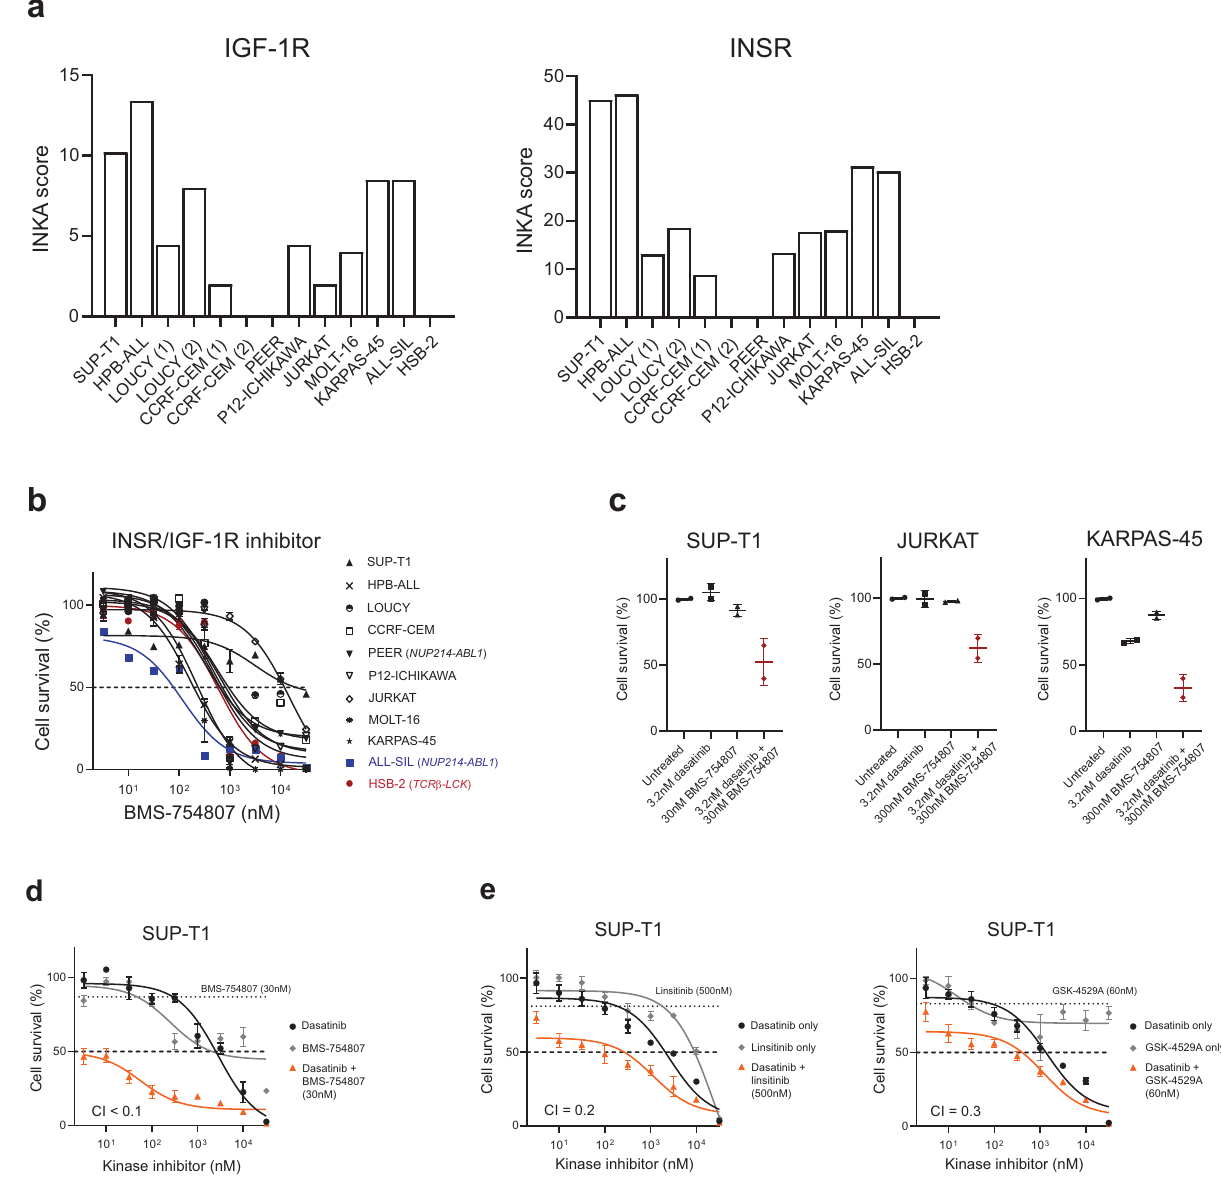
Fig. 4 IGF-1R inhibition can sensitize cells to dasatinib treatment. a Bar plots of the INKA scores inferred from the pY dataset for IGF-1R and INSR in each cell line. b Dose-response curves of BMS-754807 treatment in 11 T-ALL cell lines. Cells were treated with increasing concentrations of the INSR/IGF-1R inhibitor BMS-754807 (3.2 nM – 32 µ M range) in duplicates. Cell survival after 72 h was calculated in comparison to the untreated control. Each point represents the mean and the standard deviation of the duplicates. c Sensitivity to dasatinib, BMS-754807 and the combination of 3.2 nM dasatinib with the IC 20 concentration of BMS-754807 (30 – 300 nM) for SUP-T1, Jurkat and KARPAS-45 cells. Data is shown as mean and standard deviation of two independent experiments performed in triplicate. d Dose-response curves of dasatinib, BMS-754807 and combination of dasatinib and a fi xed concentration of BMS-754807 treatment in SUP-T1 cells. Cells were treated for 72 h with increasing concentrations of either dasatinib or BMS-754807 alone or with a combination of dasatinib (3.2 nM – 32 µ M range) with a fi xed concentration of BMS-754807 (30 nM, corresponding to the IC 20 of the single treatment for SUP-T1 cells indicated by the dotted line), in triplicate. Cell survival was calculated in comparison to the untreated control. The graph is representative of three independent experiments. CI combination index. e Dose-response curves of dasatinib, linsitinib, GSK-4524A and combination of dasatinib and a fi xed concentration of either linsitinib or GSK-4529A treatment in SUP-T1 cells. Cells were treated for 72 h with increasing concentrations of dasatinib or linsitinib/GSK-4529A alone or with a combination of dasatinib (3.2 nM – 32 µ M range) with a fi xed concentration of linsitinib (500 nM, corresponding to the IC 20 of the single treatment for SUP-T1 cells indicated by the dotted line) or GSK-4529A (60 nM, corresponding to the IC 20 of the single treatment for SUP-T1 cells indicated by the dotted line), in triplicate. Cell survival was calculated in comparison to the untreated control. The graph is representative of three independent experiments. CI combination index. Source data are provided as a Source Data fi le.